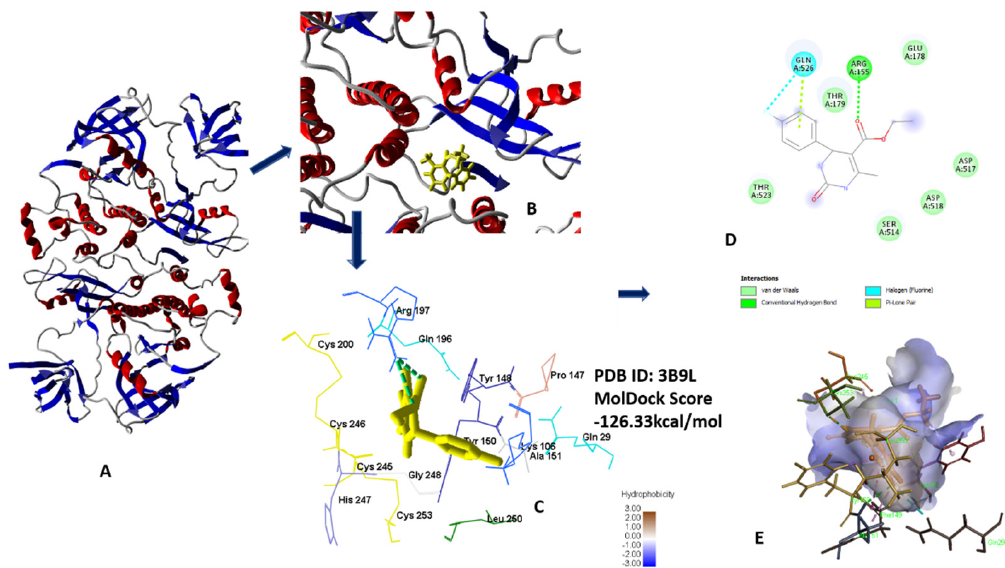
Figure 12. ( A ) Secondary Structure of 3B9L; ( B ) secondary structure along with lead compound 5c ; ( C ) 3D interaction with protein; ( D ) 2D diagram; ( E ) hydrophobic interaction of 5c with 3B9L.